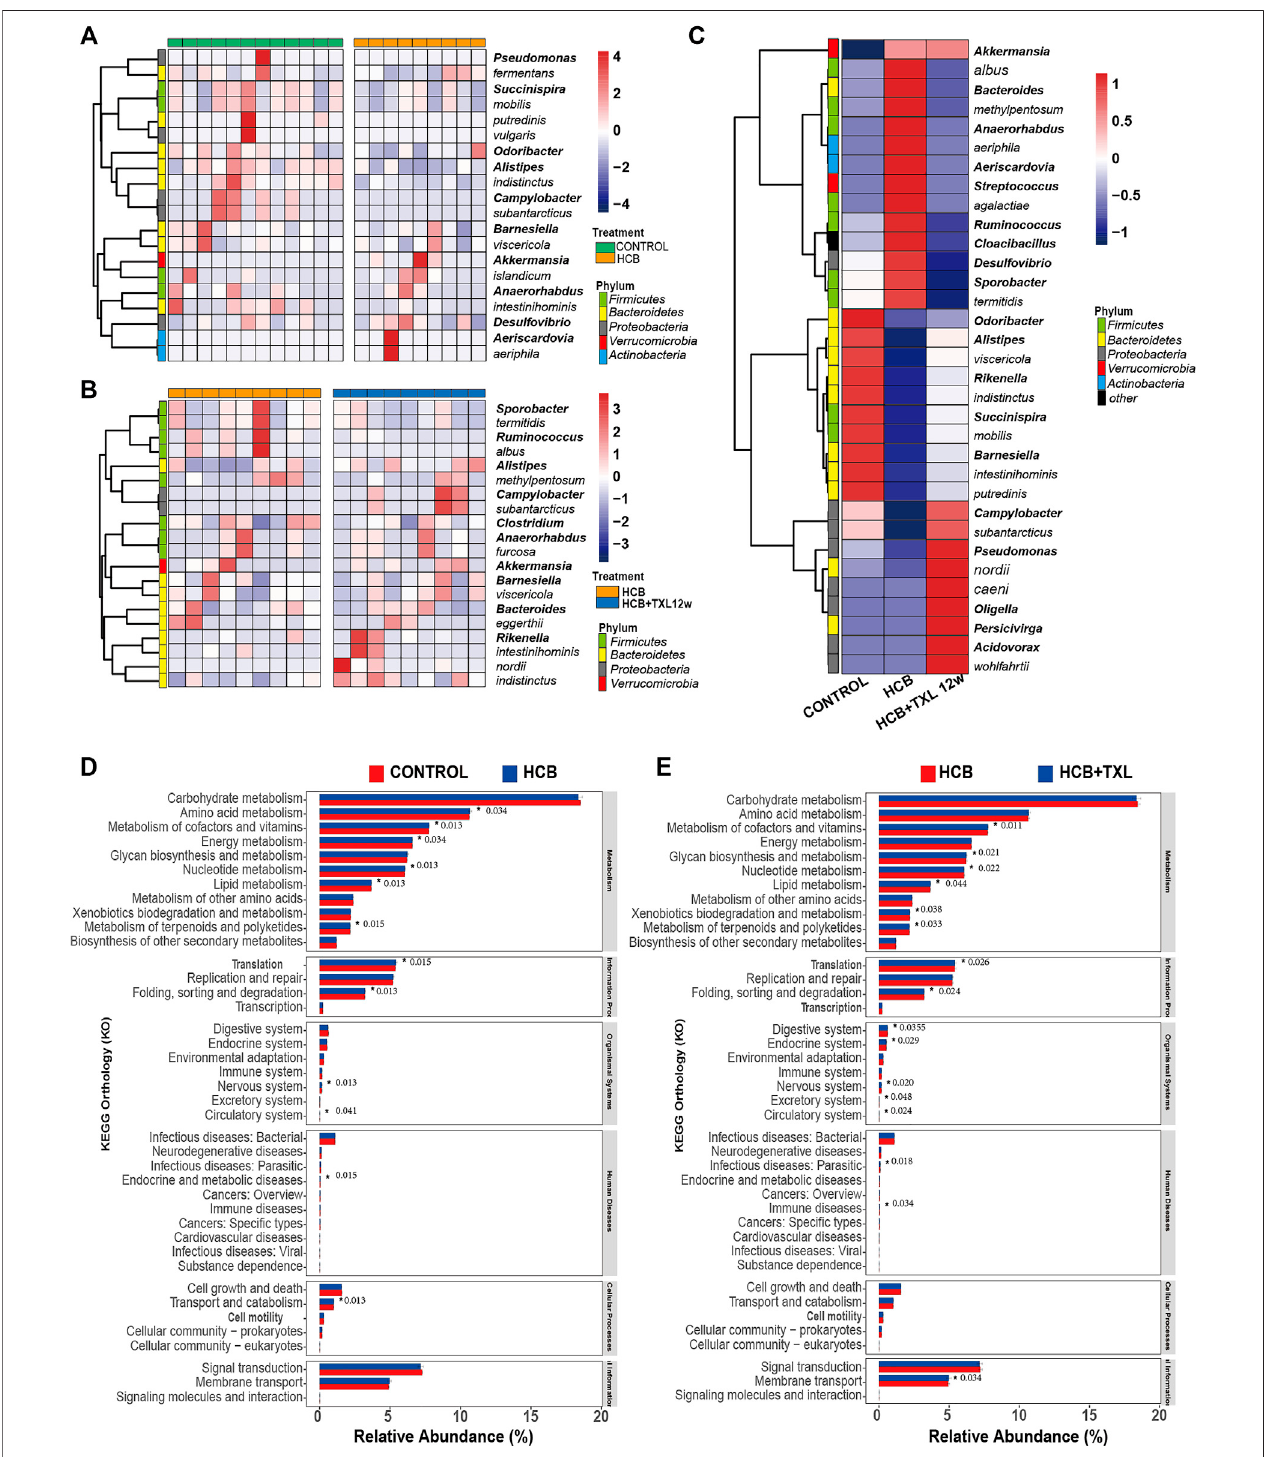
FIGURE 4 | TXL changes the relative abundances of intestinal bacteria (A) Heatmap of the relative abundances of the 20 most abundant intestinal bacteria which signi fi cantlychanged inHCB (n=9)compared withthoseinCONTROL (n=12) group(FDR-adjusted p < 0.05,FDR < 5%) (B) Heatmap oftherelativeabundancesofthe 20 most abundant intestinal bacteria which were signi fi cantly changed in HCB + TXL 12w treatment (n = 12) compared with those in HCB (n = 12) group (FDR-adjusted p < 0.05, FDR < 5%) (C) Heatmap of the relative abundances of the 33 most abundant intestinal bacteria which were signi fi cantly changed in CONTROL (n = 12), HCB (n = 9) and HCB + TXL 12w treatment (n = 10) groups ofthe rabbits(FDR-adjusted p < 0.05, FDR < 5%). The color bar indicates Z score that represents the relative abundance. Z score < 0 and > 0 means the relative abundance is lower and higher than the mean. Row names thickened represent bacteria genus, otherwise represent bacteria species. (D,E) Tax4Fun predicts the function of microorganisms in the sample. *: p < 0.05, the number after the “ * ” are p value.